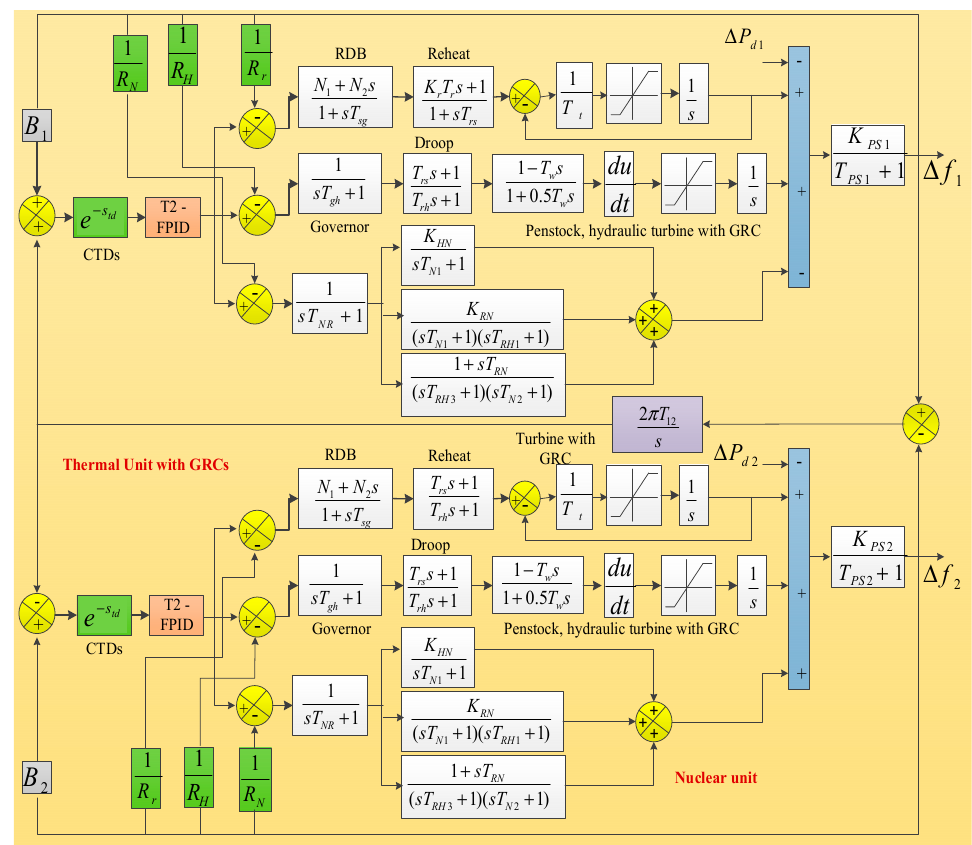
Figure 1. Dual-area conventional hydro-thermal plant (DAHT) (test system 1) [24].